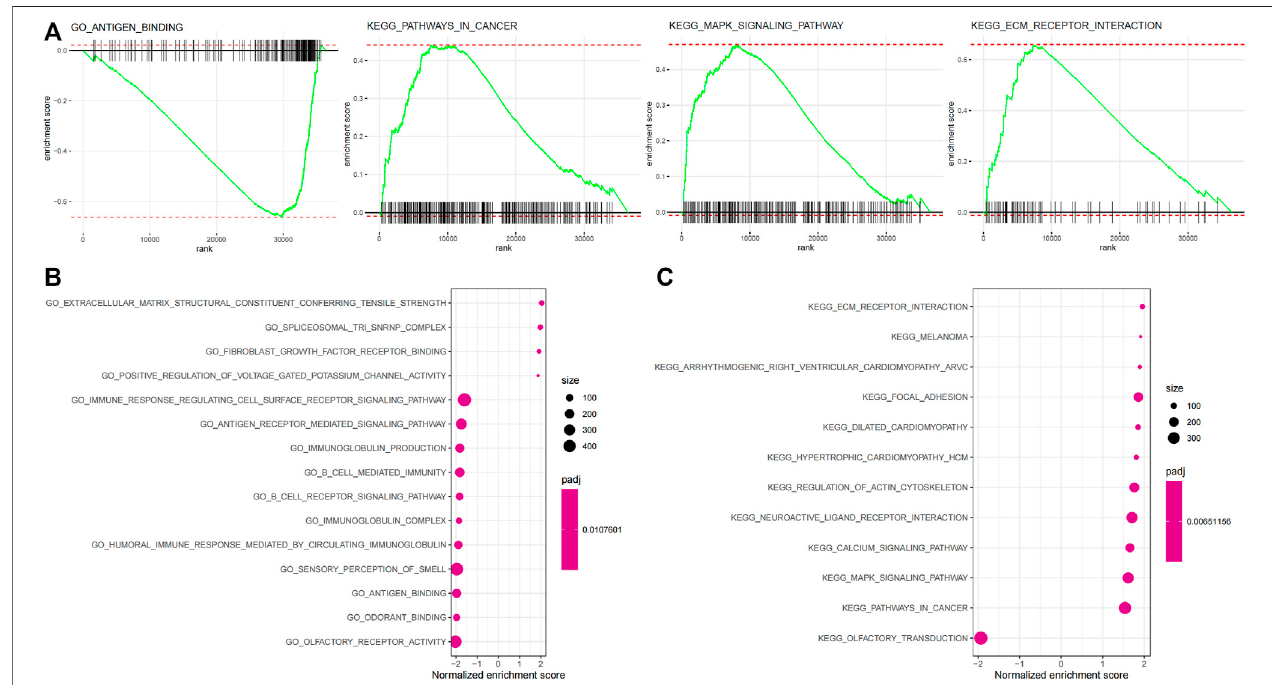
FIGURE 4 | Enrichment analysis of the 45-IRGP signature. (A) GO enrichment analysis and (B) KEGG enrichment analysis.